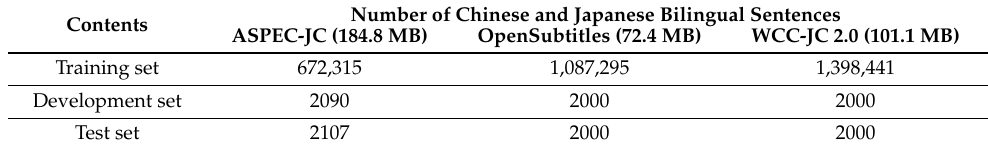
Figure 3. Sentence length distribution for WCC-JC 2.0. The length of more than 60 characters is exceeded by 5 Chinese sentences and 73 Japanese sentences. Table 6. An elaborate account of the bilingual corpora in Japanese and